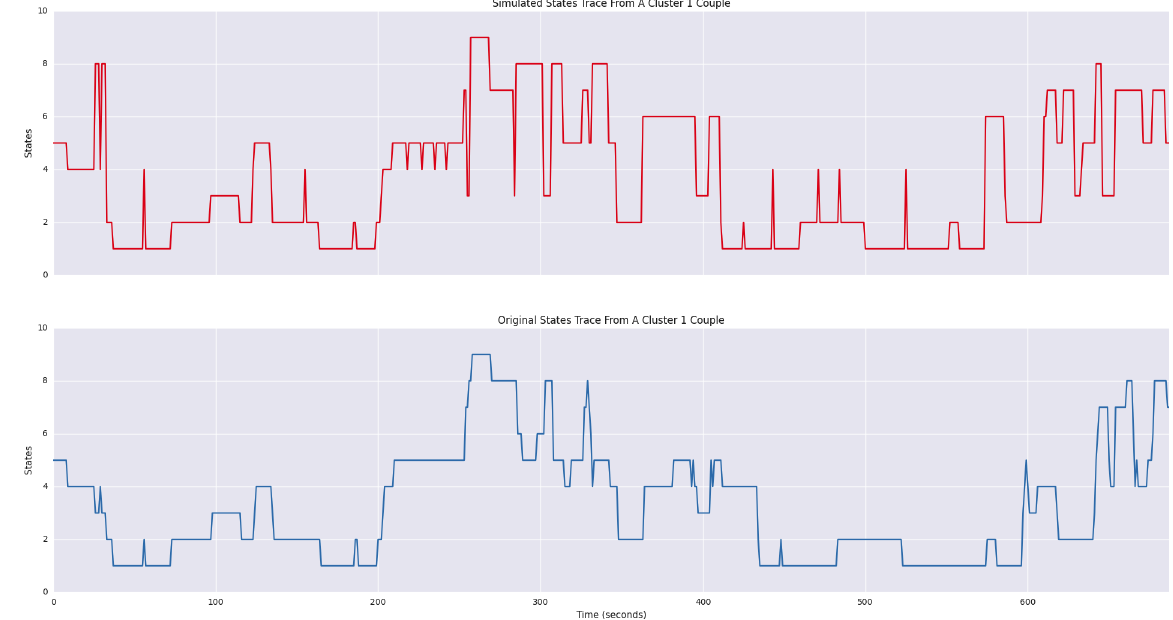
Fig 9. Simulated Sequence Of Dyadic States From Cluster 1. The realized States sequence derived from male-female affect scores is shown below the simulated